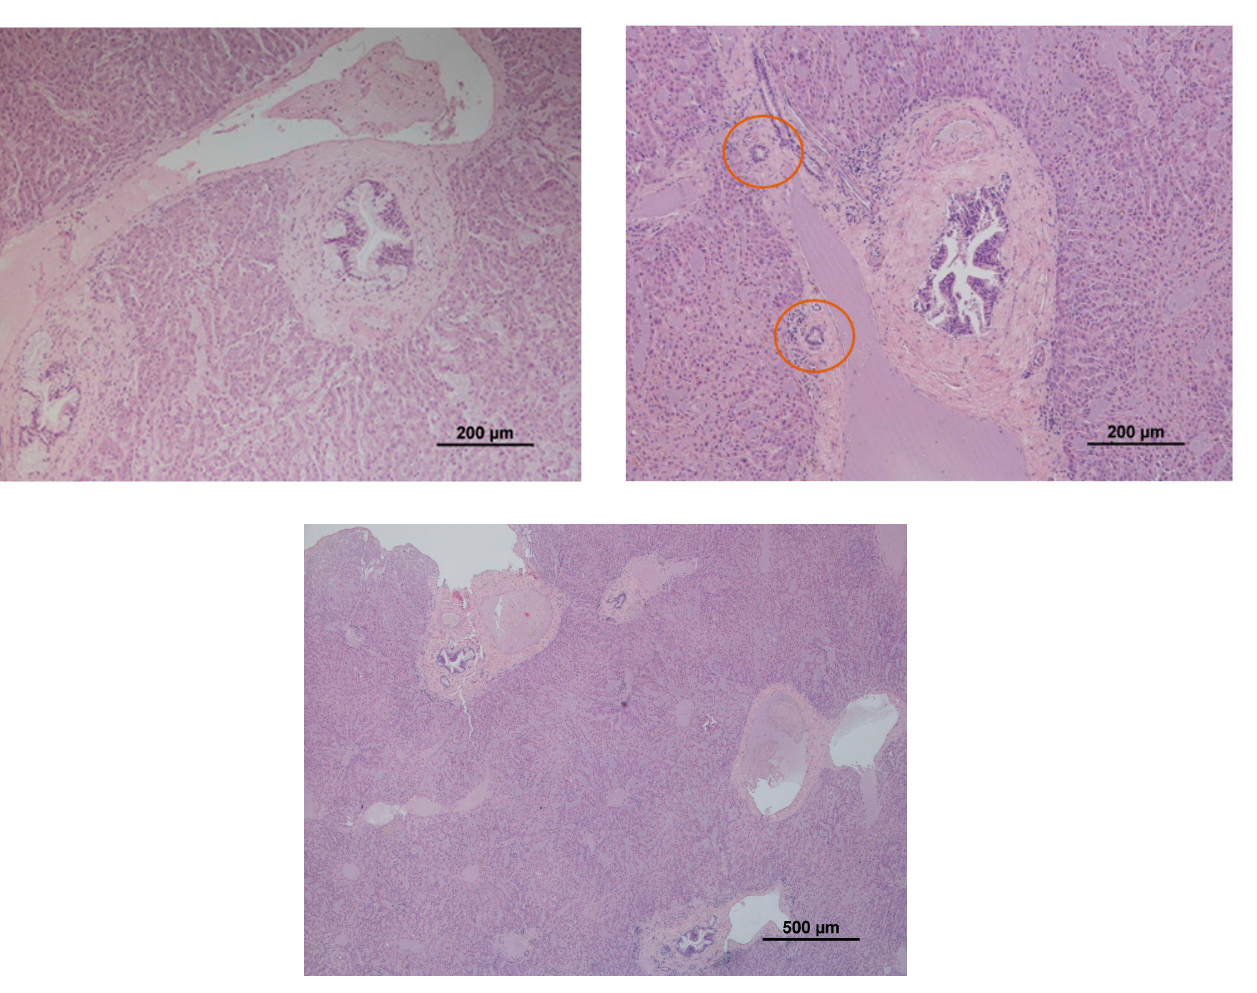
Figure 1. Evidence of biliary hyperplasia detected in a hedgehog’s liver (evident enlarged duct walls and lumen). Orange circles indicate some normal biliary ducts for comparison. Note that the hedgehog carcasses were frozen before the necropsy, so it is possible to notice some freezing artefacts.